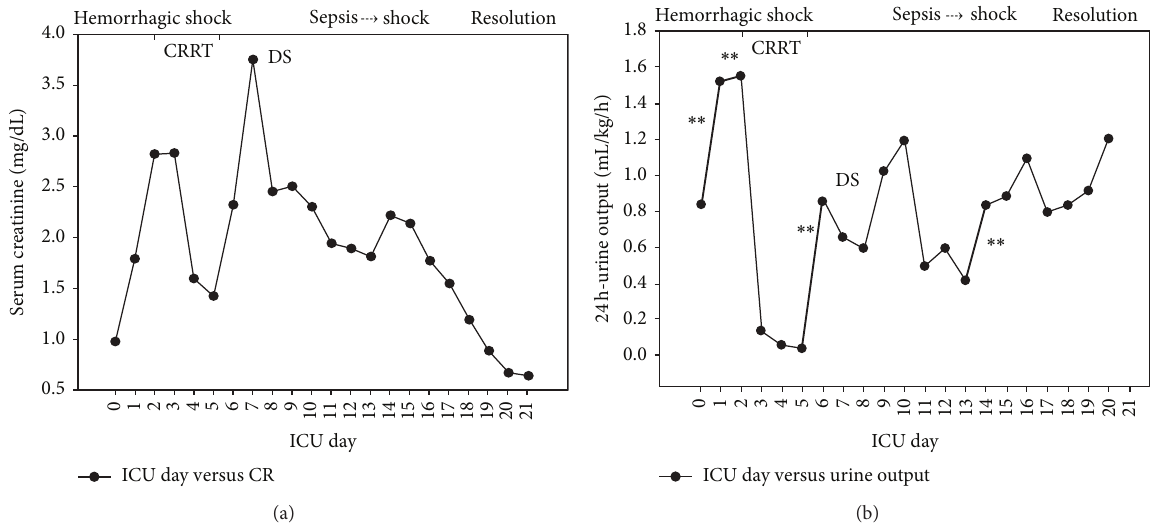
Figure 2: Serum creatinine (a) and urine output (b) in the course of hemorrhagic shock and subsequent septic shock. Bold lines with ∗∗ represent the periods in which furosemide was administered. CRRT: continuous renal replacement therapy DS: conventional dialysis. ICU: intensive care